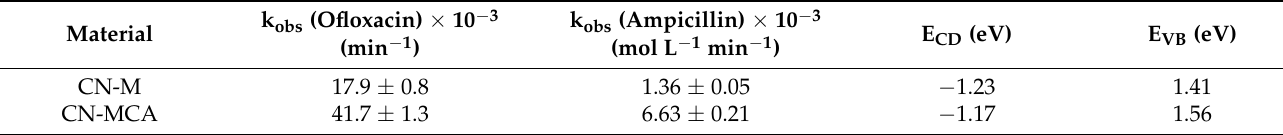
Table 4. Observed kinetic constants, E CD and E VB values of CN